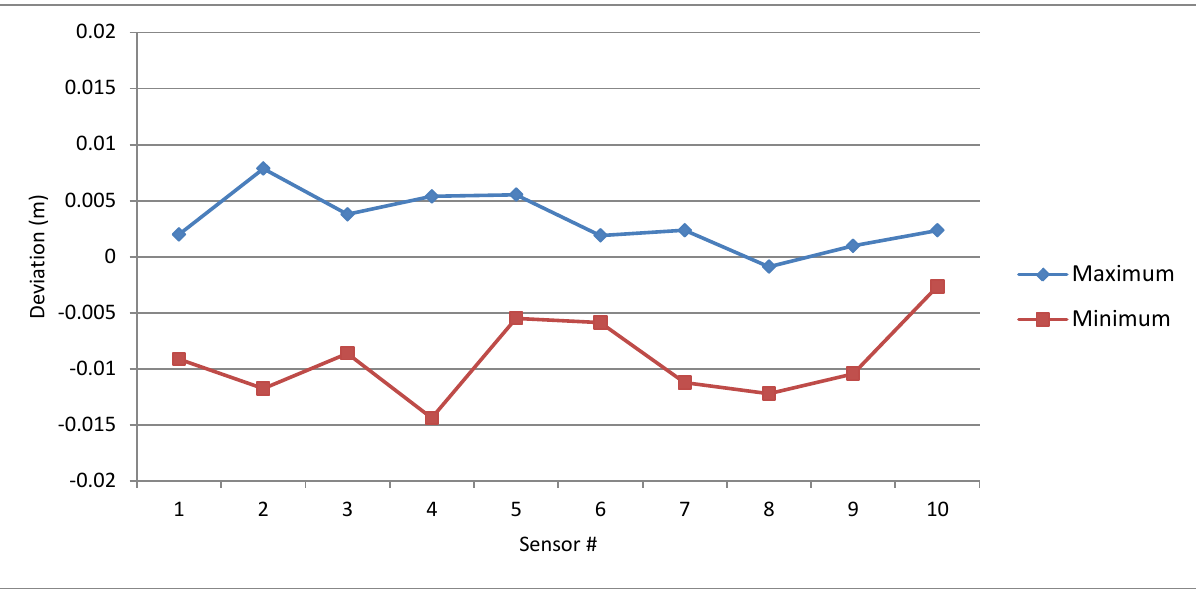
Figure 5. Maximum and minimum sphere spacing error of 10 different sensor units.